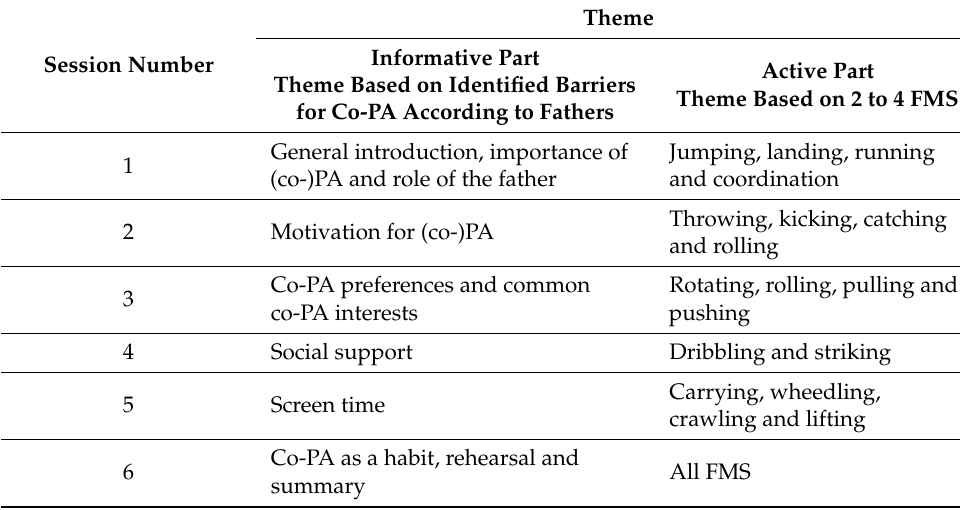
Figure 2. Timeline of an (inter)active father-child session. Table 4. Overview of the different themes derived from the co-creation sessions.